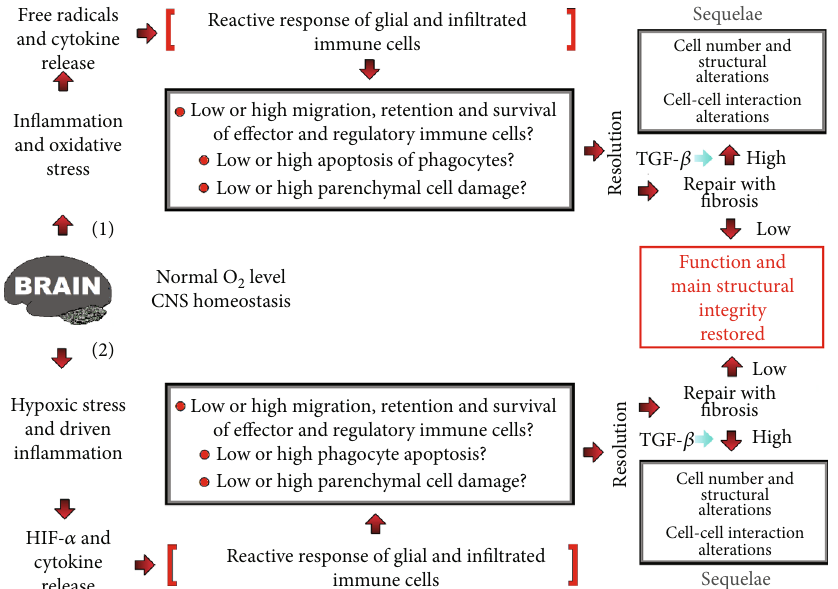
Figure 4: Hypoxic and nonhypoxic in fl ammation and neuroimmune interactions involved in the prohemostatic response in the CNS. Brain parenchyma, the functional tissue, comprises neurons and glia cells. Brain damage or trauma often leads to cognitive deterioration and/or motor disability with parenchyma structural alterations and eventual cell death. Triggering (1) nonhypoxic and (2) hypoxic reactive in fl ammation might subserve functional postinjury recovery. Oxidative stress by a high oxygen level induces a compensatory antioxidant response to cut out damage progression. At the other end, hypoxia (hypoxic stress) by a low oxygen level upregulates pathways involved in boosting the oxygen supply. In any case, a fault in oxygen homeostasis draws in fl ammation with immune cell in fi ltrates and resident glial cells to restore homeostasis. Light-blue arrow: regulation; red arrow: